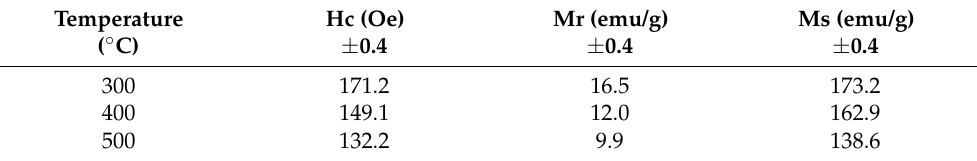
Figure 11. Hysteresis loops of the sintered Nd 2 Fe 14 B/Fe 90 Al 10 system at 300, 400 and 500 °C, respec- tively. Table 9. Extrinsic magnetic properties of the Nd 2 Fe 14 B system. Fe 90 Al 10 sintered at 300, 400 and 500 ◦ C,